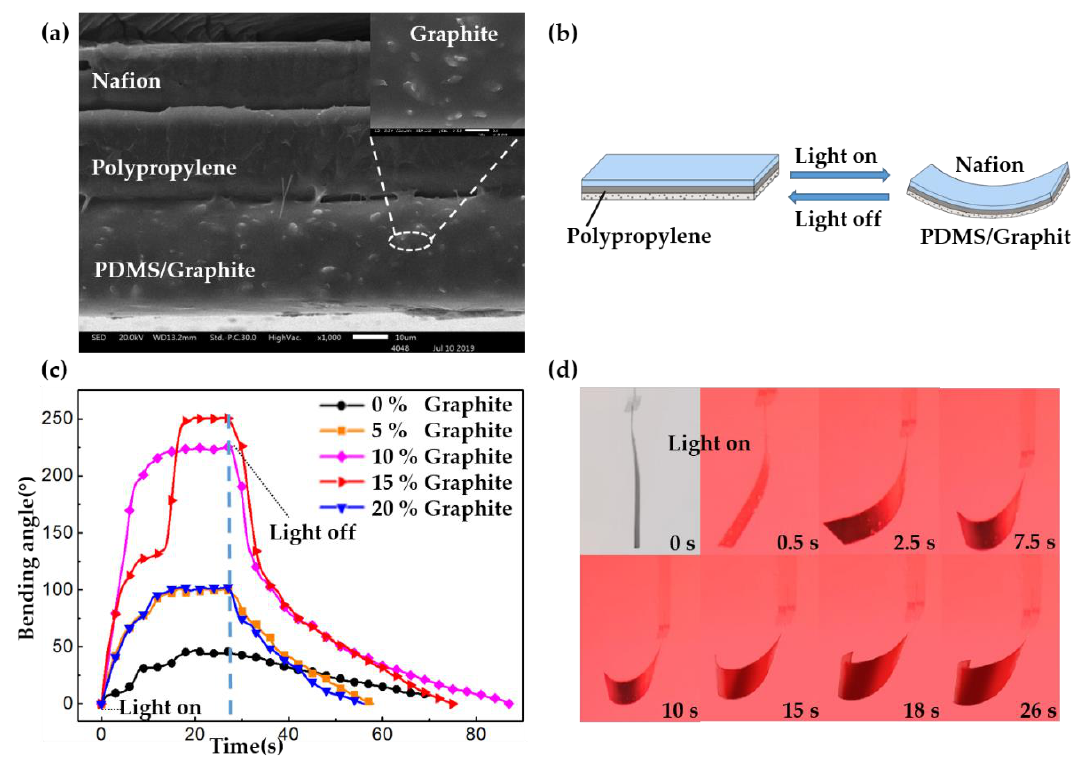
Figure 3 . Optical-responsive behavior of the multilayer membrane (the test ambient relative humidity was 30%). ( a ) SEM image of the cross-section of the Nafion-polypropylene-PDMS / Graphite multilayer membrane. ( b ) Schematic illustration of the reversible deformation behaviors under illumination. ( c ) Bending angle of the actuator with di ff erent graphite particle concentrations under the NIR light intensity of 0.88 W · cm − 2 . ( d ) Real-time process of light response of the multilayer membrane with 15% graphite concentration.